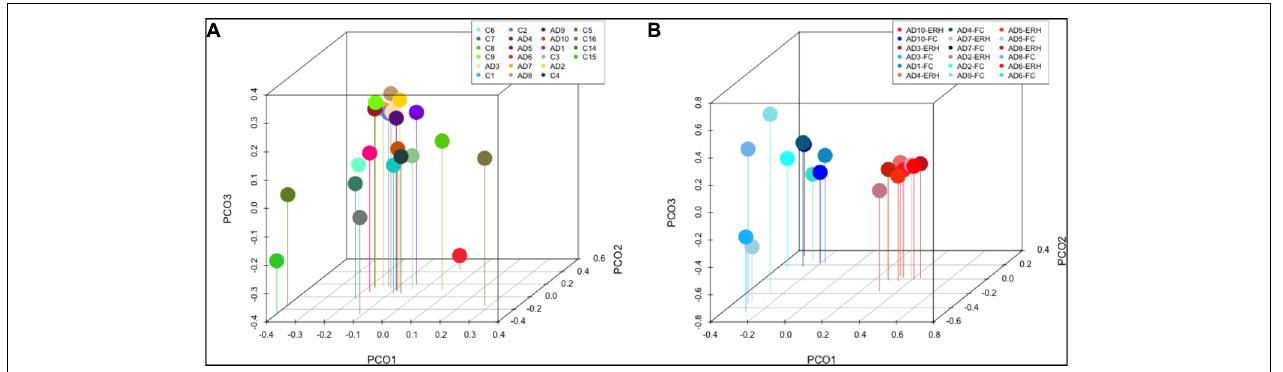
FIGURE 7 | Principal component analysis of AD and control samples: 3D principal component analysis scatter plots of AD patients and controls. Distribution between ten AD patients using FC samples, nine control ERH samples, two Superior Frontal Gire control samples (C14 and C15), and one Parietal cortex control sample (C16) (A) . Distribution between ten AD patients using FC samples (plots in blue) and nine ERH samples (plots in red) (B) . The UniFrac method was used to calculate this